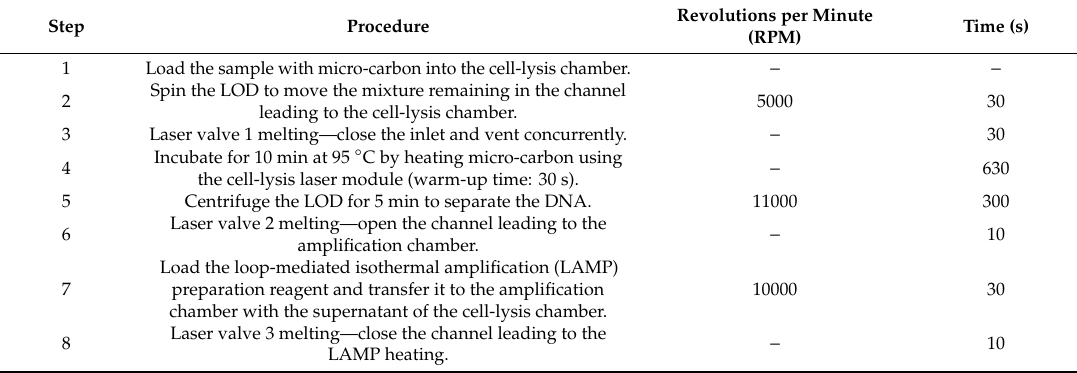
Table 1. Summary of the LOD-platform experimental procedure for DNA cell lysis.